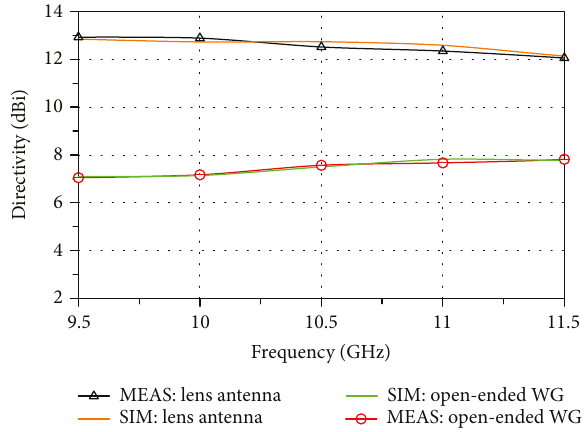
Figure 13: Comparison of the maximum directivity of the proposed lens and an open-ended